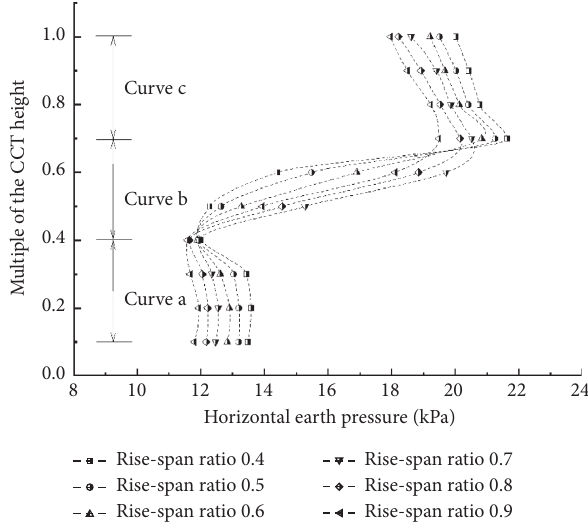
Figure 8: Variation of lateral earth pressure for case S1 on the side of CCT.